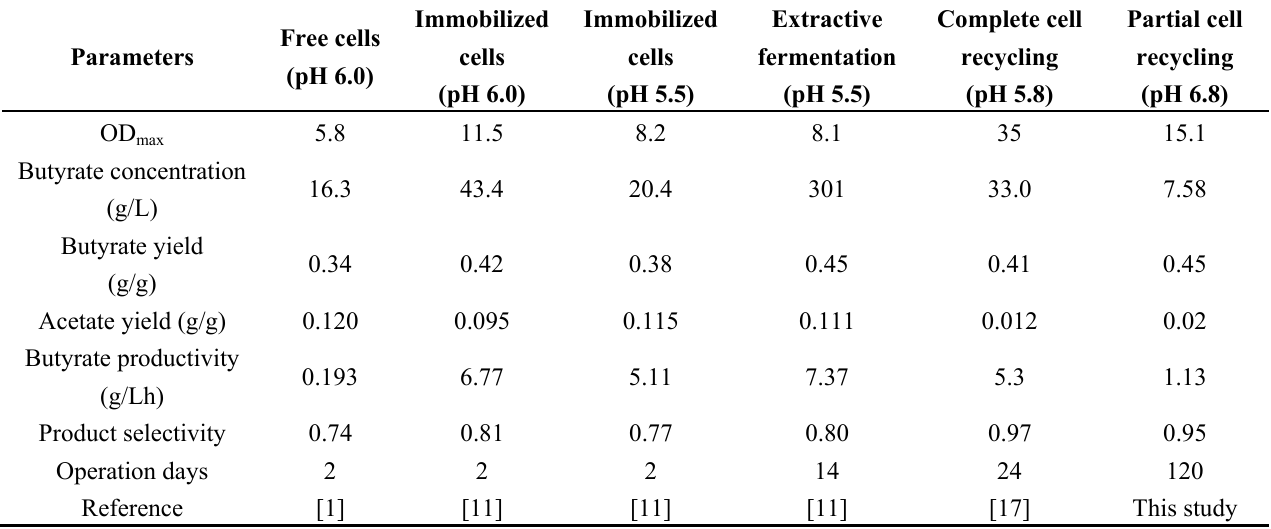
Table 1. Comparison of fermentation results from free cells, immobilized cells, extractive fermentation, and this